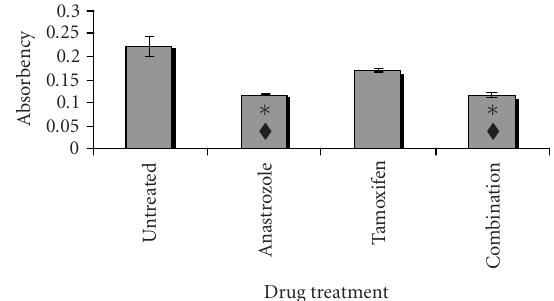
Figure 5. Cell proliferation assay results utilizing absorbency (450nm) as a measure of viability in cells untreated or treated with anastrozole (50 µ g/mL), tamoxifen (5 µ g/mL), or the com- bination (anastrozole and tamoxifen). Stars indicate a statistical di ff erence from the untreated groups ( P ≤ . 05). Diamonds indi- cate a statistical di ff erence from the tamoxifen group ( P ≤ . 05). Bars represent ±